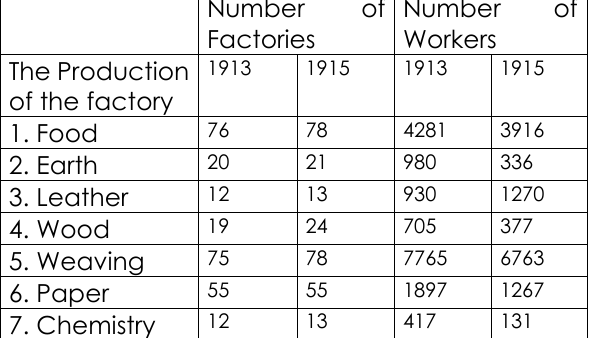
Table 1. The number of factories and workers according to the statistics of